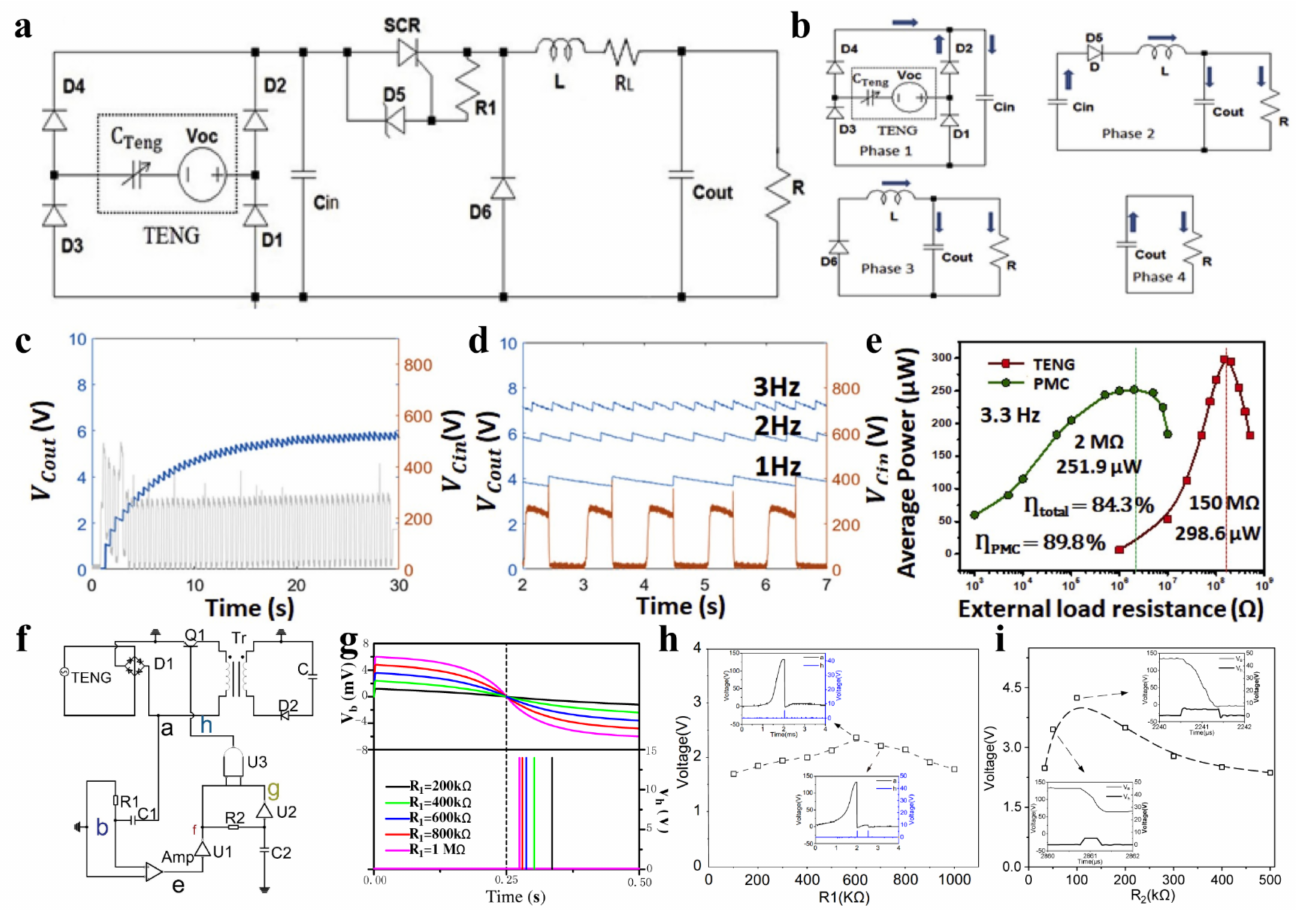
Figure 8. Power management with silicon-controlled rectifier (SCR) and triode. ( a ) Power manage- ment circuit with SCR. ( b ) Energy flow in four stages. ( c ) The voltage waveforms of C in and C out . ( d ) The dependence of C in and C out voltage on frequency. ( e ) Average output power under different loads with/without power management. Reproduced with permission [66]. Copyright 2020, Elsevier. ( f ) Power management circuit with triode. ( g ) The dependence of V b and V h on different value of R 1 . ( h ) The optimum value of R 1 . ( i ) The optimum value of R 2